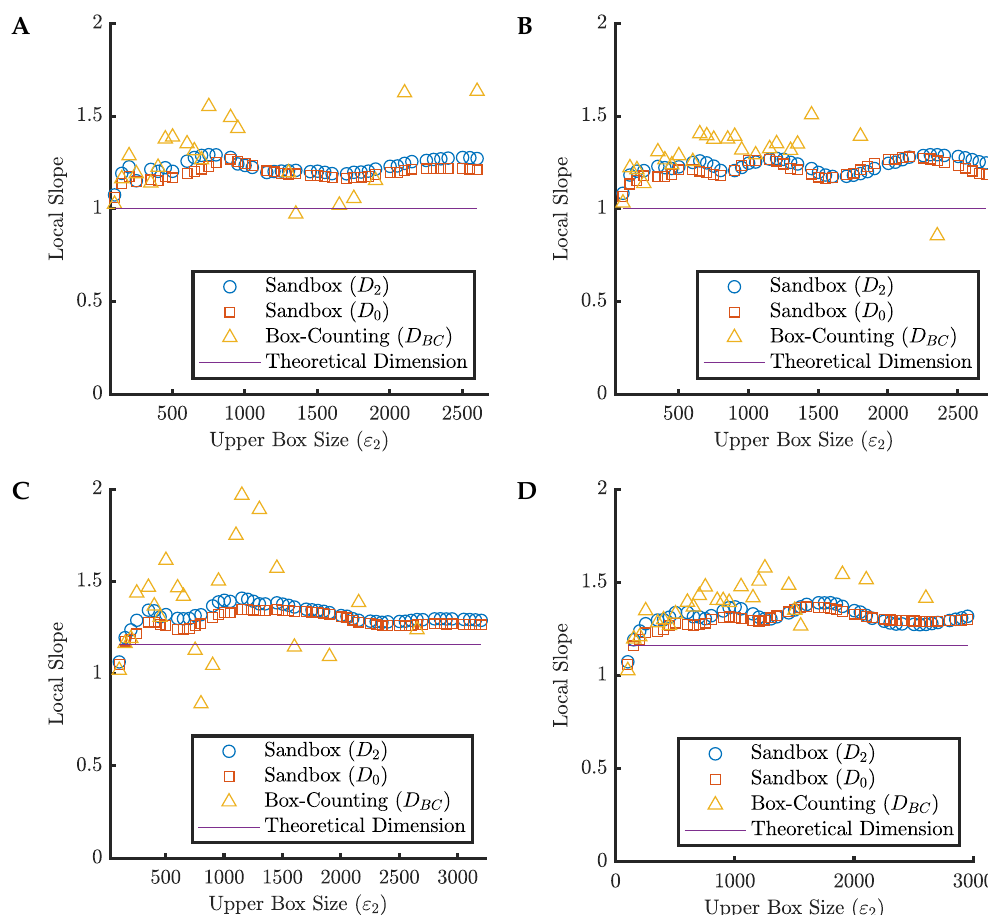
Figure 8. Plots showing the local slopes as a function of the upper box size ε 2 for four distinct fractal trees. ( A ) r = 0.5, θ = π